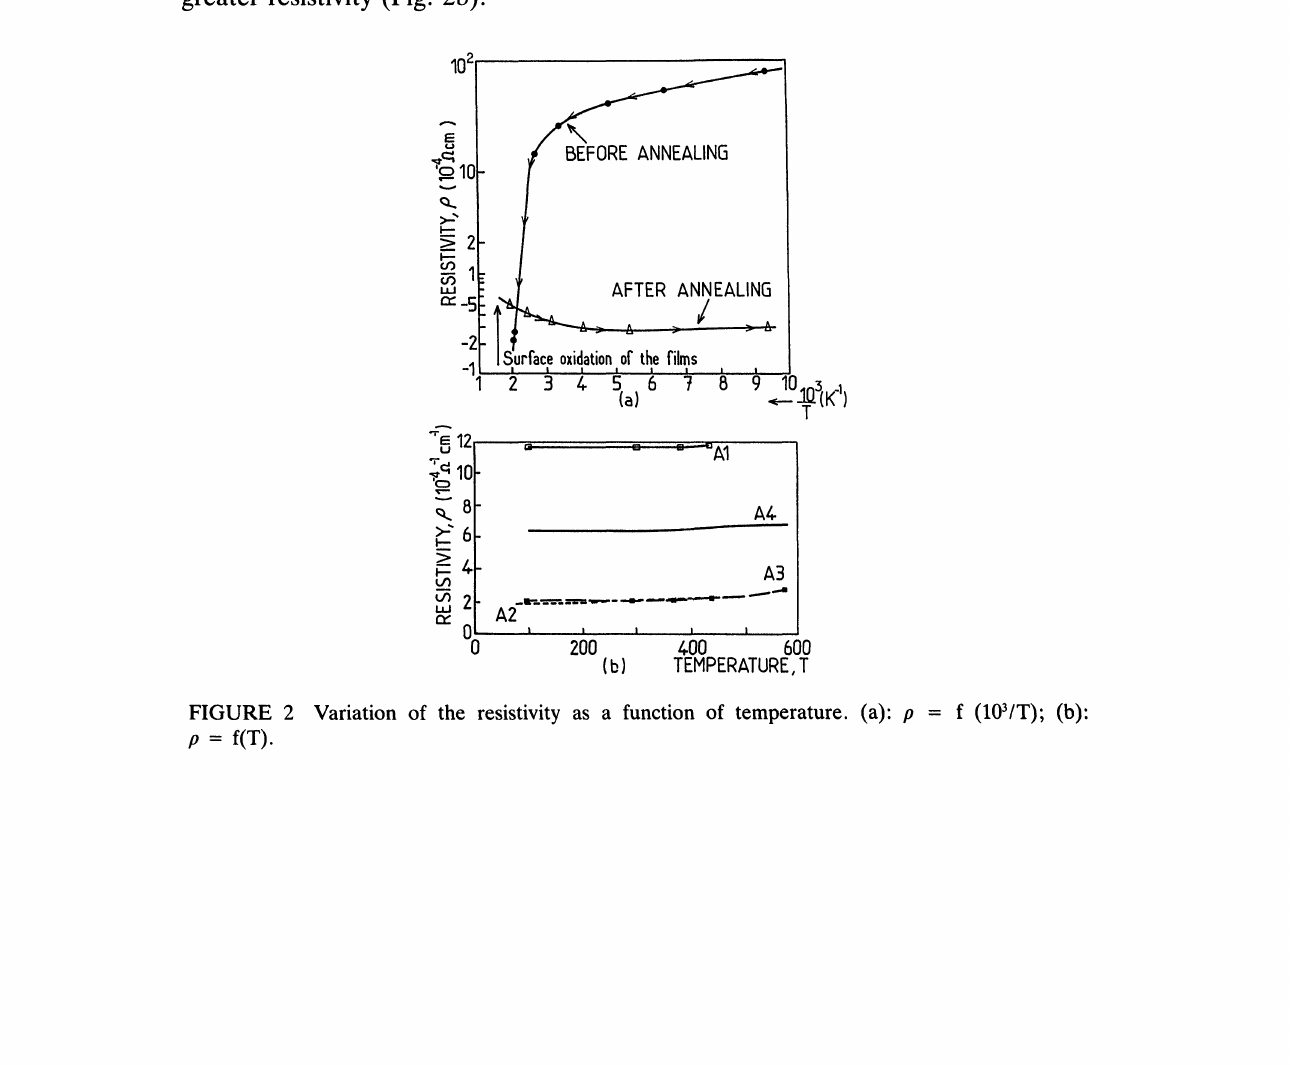
FIGURE 2 Variation of the resistivity as a function of temperature. (a): p (103/T); (b): p